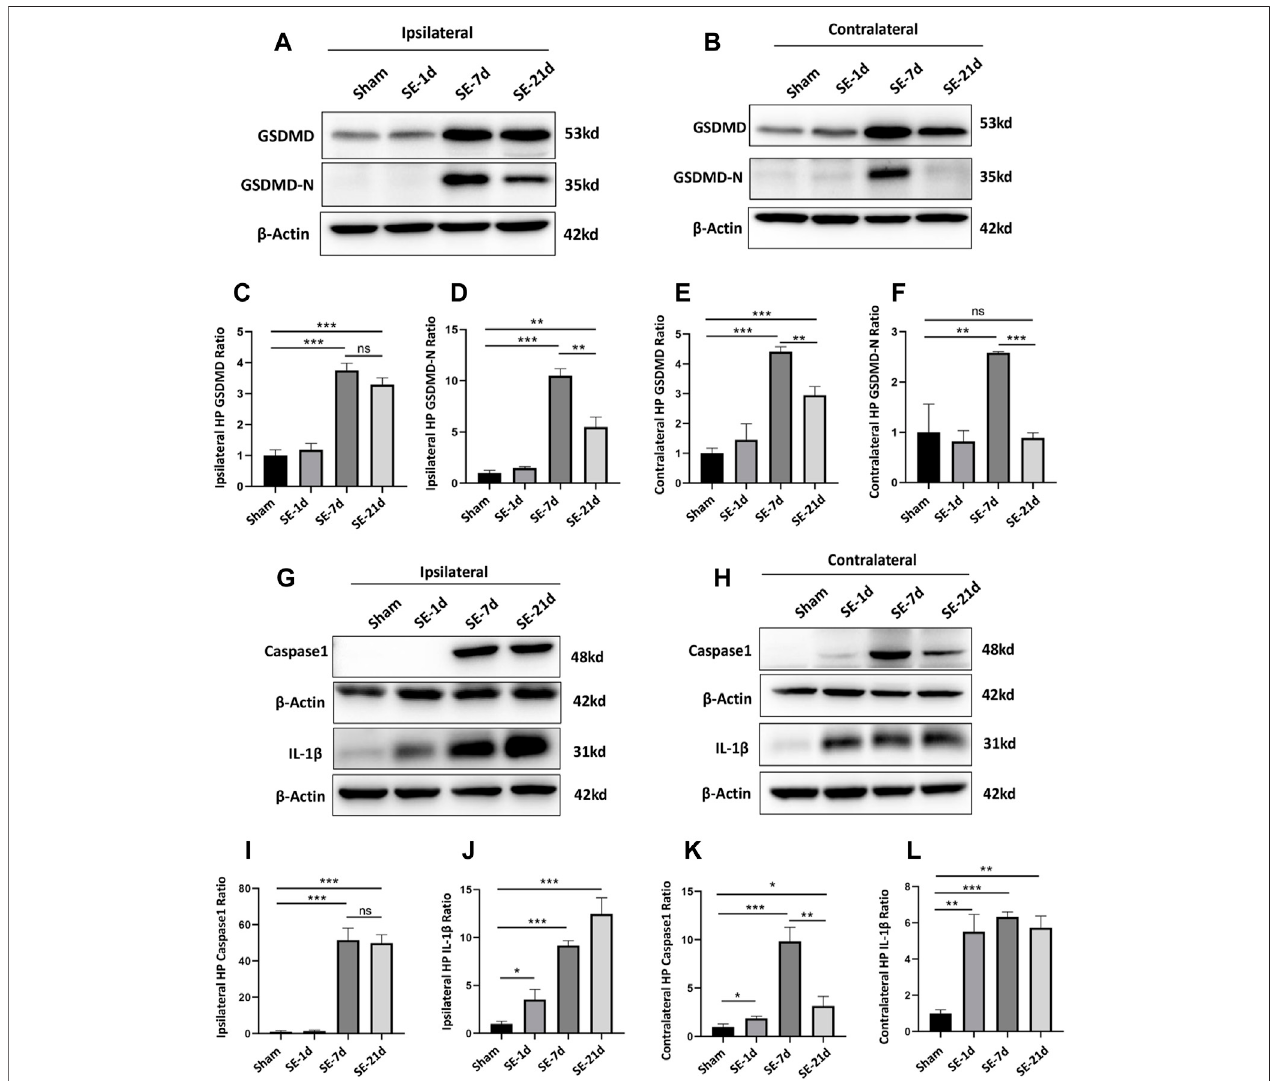
FIGURE 1 | Expression of GSDMD and pyroptosis-related molecules was signi fi cantly increased after kainic acid-induced SE. (A, B) WB bands of GSDMD, GSDMD-N and β -actin proteins in the ipsilateral and contralateral hippocampus. (C – F) Statistical analyses of GSDMD, GSDMD-N and β -actin proteins in the ipsilateral and contralateral hippocampus. (G, H) WB bands of caspase-1, IL-1 β , and β -actin proteins in the ipsilateral and contralateral hippocampus. (I – L) Statistical analyses of caspase-1, IL-1 β , and β -actin proteins in the ipsilateral and contralateral hippocampus (n (cid:1) 3 in each group, * p < 0.05, ** p < 0.01, and *** p <